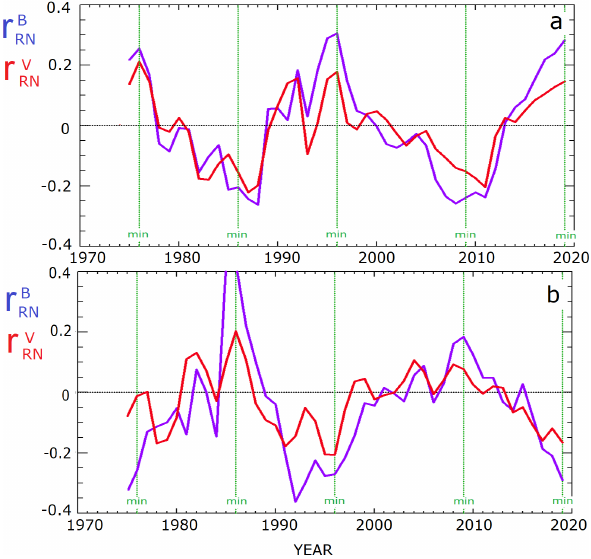
Figure 1. Correlation between radial (R) and normal (N) components of magnetic field ( blue line ) and velocity ( red line ) as functions of time, (a) – for positive magnetic sector, (b) – for negative magnetic sector. Vertical green lines mark minima of solar activity